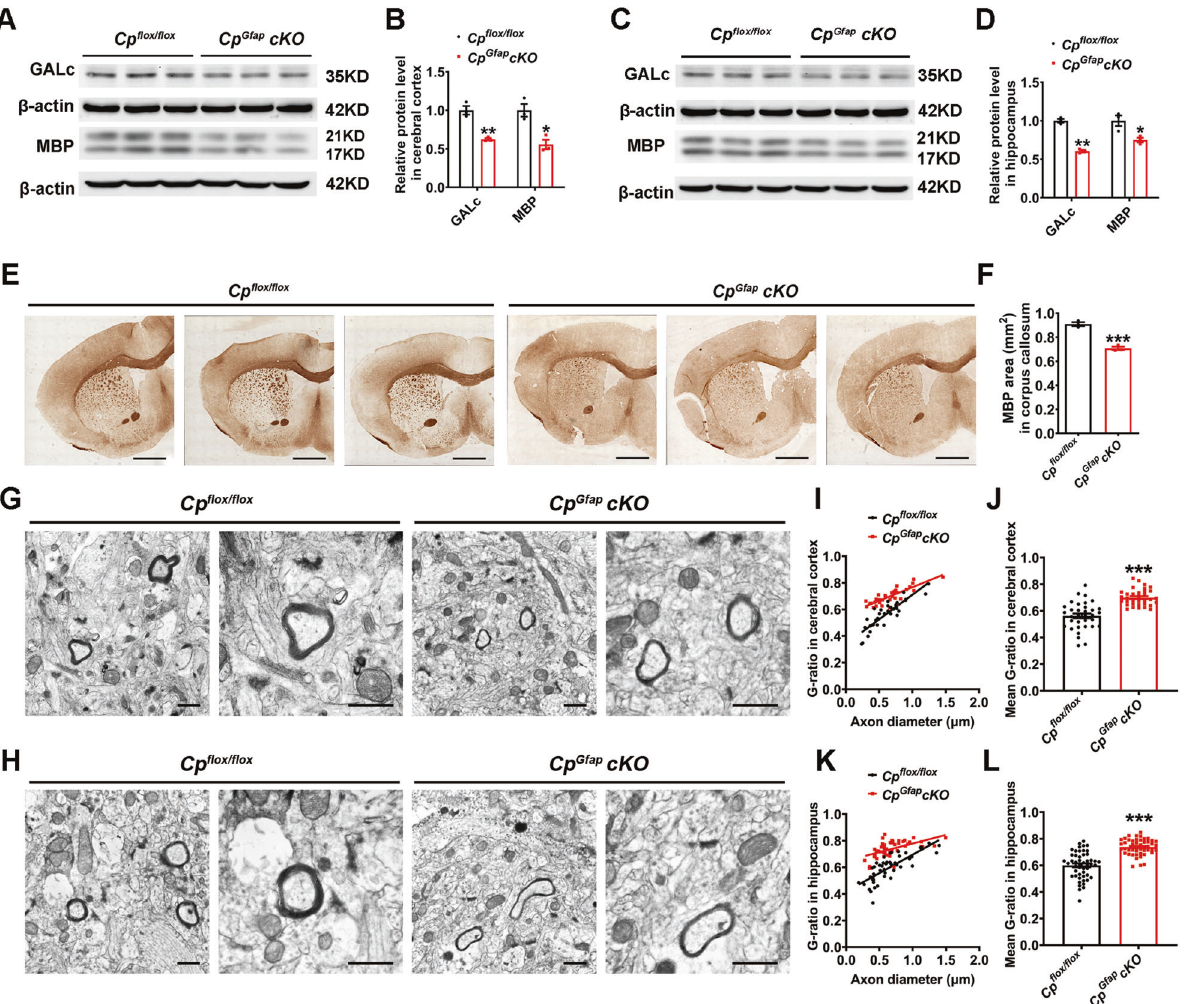
Fig. 2 Impairment of myelin formation in the brain of Cp Gfap cKO mice. A-D Western blot analysis of GALc and MBP expression levels in the cerebral cortex ( A ) and hippocampus ( C ) of Cp fl ox/ fl ox and Cp Gfap cKO mice. Quanti fi cation of the expression of GALc and MBP in the